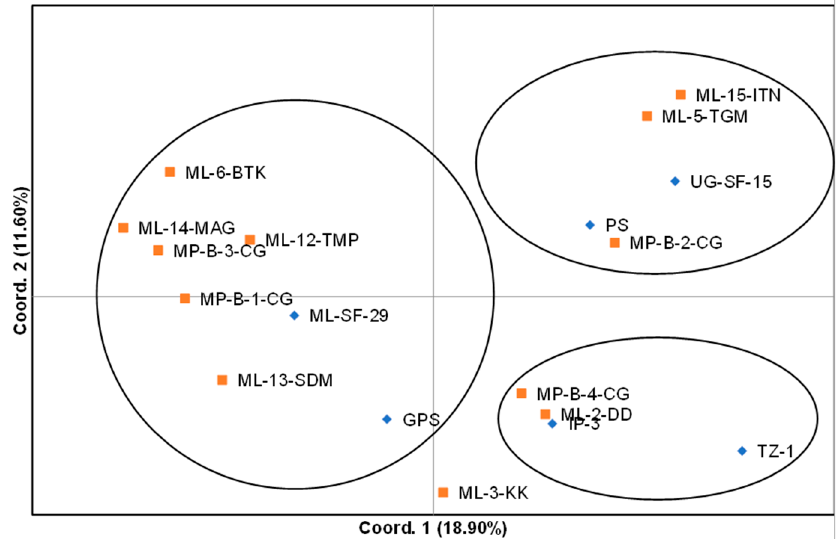
Figure 3. Principal coordinates analysis calculated from the pooled data of seven simple sequence repeat markers in 18 spider plant accessions.